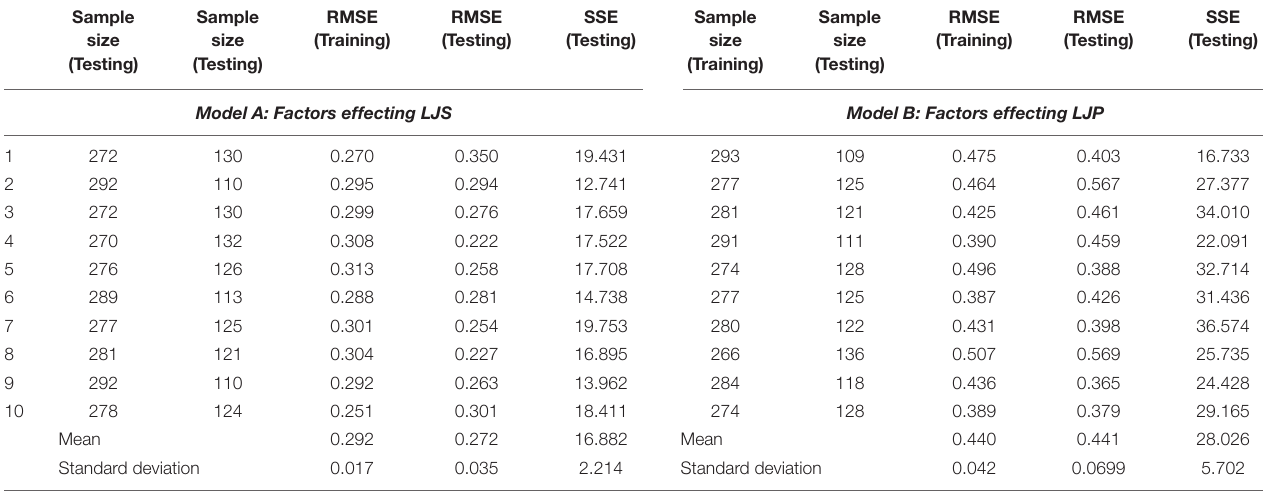
TABLE 7 | RMSE values of artificial neural networks ( N =